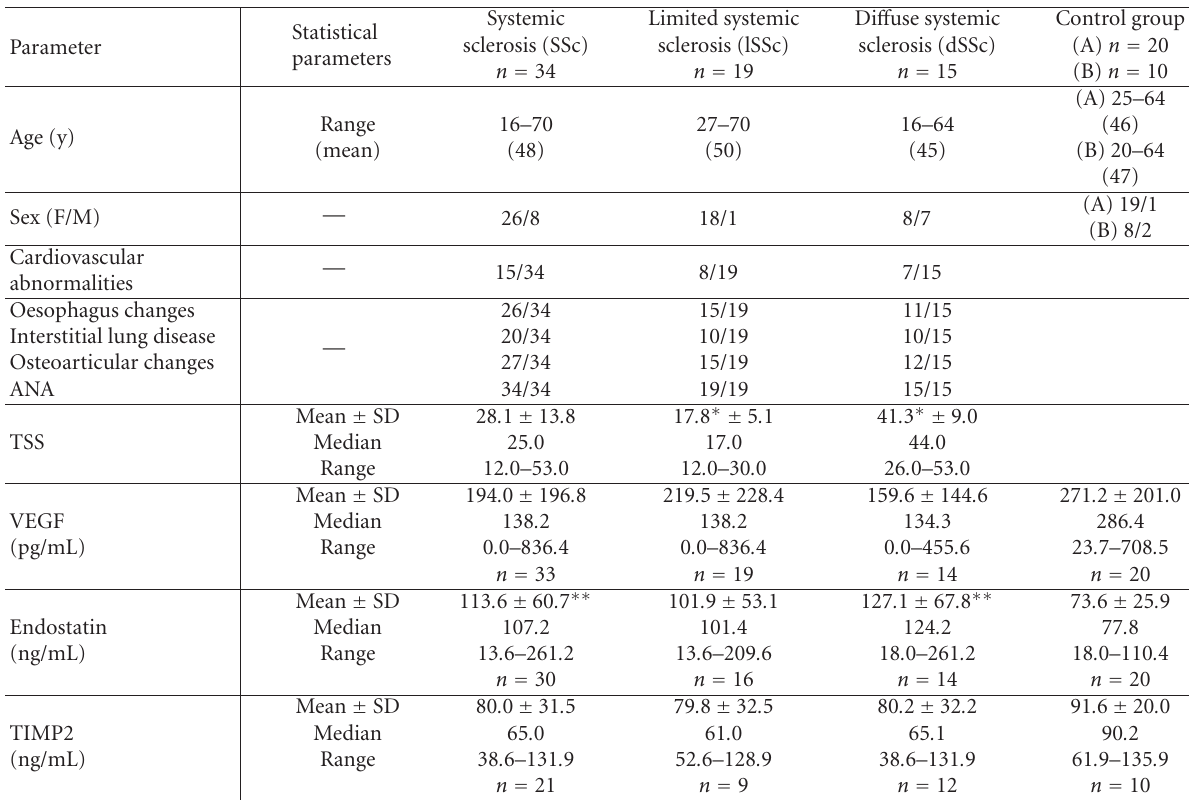
Table 1. Clinical characteristics of the examined groups. (A) denotes the control group for the examined angiogenesis factors; (B) de- notes the control group for the examined TIMP2; SD denotes the standard deviation; n is the number of patients; TSS is the total skin score; ANA denotes antinuclear antibodies. ∗ denotes statistically significant di ff erences in comparison between limited and di ff use systemic sclerosis ( P < . 05). ∗∗ denotes statistically significant di ff erences in comparison to the control group ( P < . 05). Oesopha- gal changes included oesophagal scintigraphy disturbances: swallowed passage in the lower and/or central part of the oesophagus. Cardiovascular abnormalities included tendency to tachyarhythmias, lower potentials of di ff erent parameters describing variability of cardiac rhythm or conduction system abnormalities, ventricular arrhythmia, silent ischaemic episodes, diastolic left ventricular dis- turbances, and valvular lesions. Osteoarticular changes included changes in osteoarticular system: juxta-articular demineralisation, joint space narrowing in digits. Interstitial lung disease included DLCO < 80% of predicted value with or without X-ray chest changes: symmetrical fibrosis of the lung base and “honeycomb”